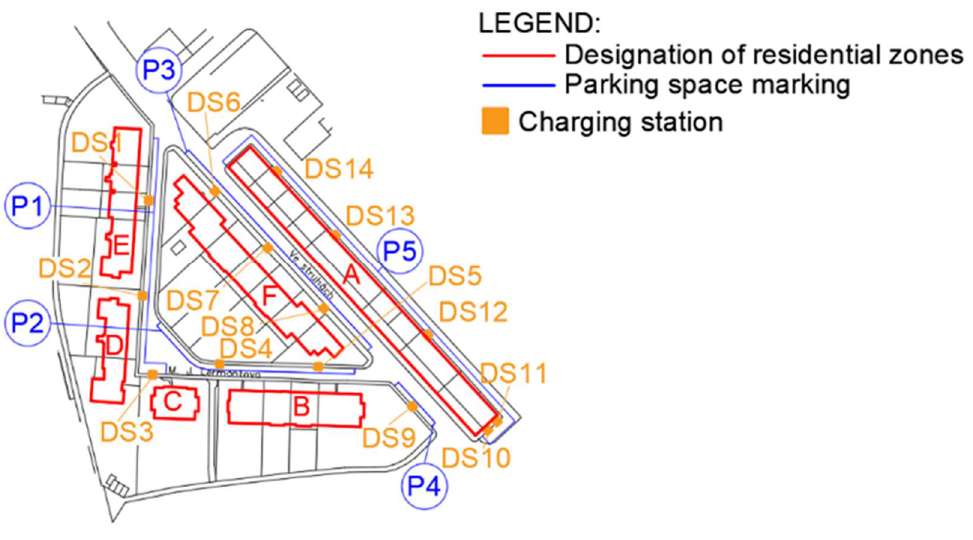
Figure 8. Solved area of M.J. Lermontova and Ve Struhách streets, Praha—Bubeneč.